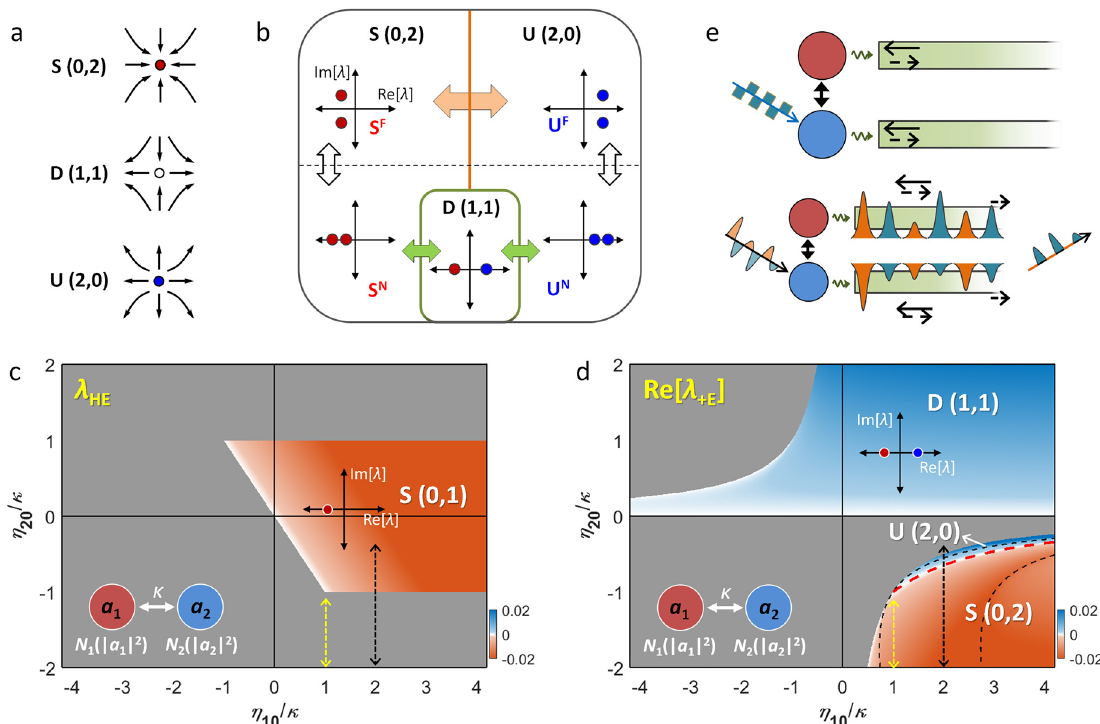
Figure 1: Topological classification. (a)Topologicalphasesin2Ddynamicalsystemsdeterminedbystatetrajectories.(b)Jacobianeigenvaluesofeachphase.Anorangeboundary between the S F and U F phases represents the AH bifurcation, while the green boundaries around the D(1,1) phase denote the saddle-node bifurcation. The black dashed line divides node and focus phases. (c and d) PT-symmetry-dependent phase diagrams. (c) λ HE for unbroken PT symmetry. (d) Re[ λ + E ] for broken PT symmetry. The red dashed line denotes the AH bifurcation, and the black dashed lines represent the boundaries between the node and focus phases. The yellow and black dashed arrows in (c and d) represent the transitions for the devices in Figures 4 and 5, respectively. A schematic of nonlinear coupled resonators is shown in the third quadrant of (c and d). η 11 / κ = − 0.5.